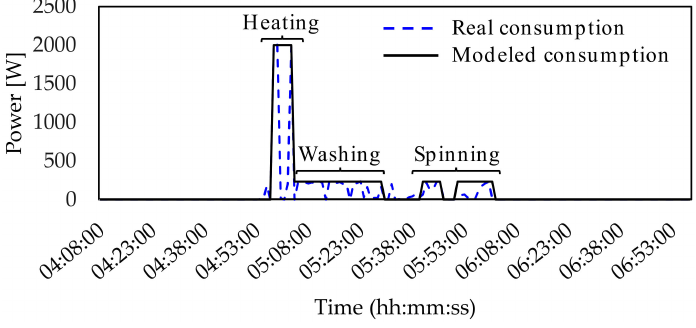
Figure 5. Example of power demand for a washing machine.